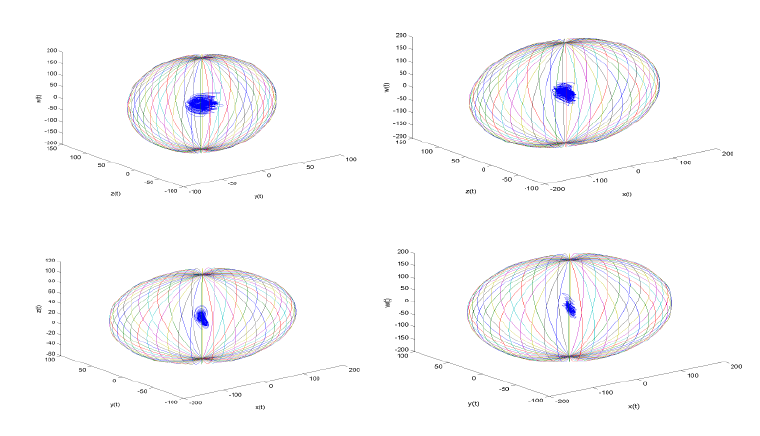
Figure 4. The trajectories of system ( 2 ) are contained in the globally exponential attractive set Ω 1,0,0 in different 3 − D projection planes, where a = 12, b = 23, c = 1, d = 2.1, k = 6, r = 0.2 and the initial state ( x 0 , y 0 , z 0 , w 0 ) = ( 0.1,0.1,0.1,0.1 )